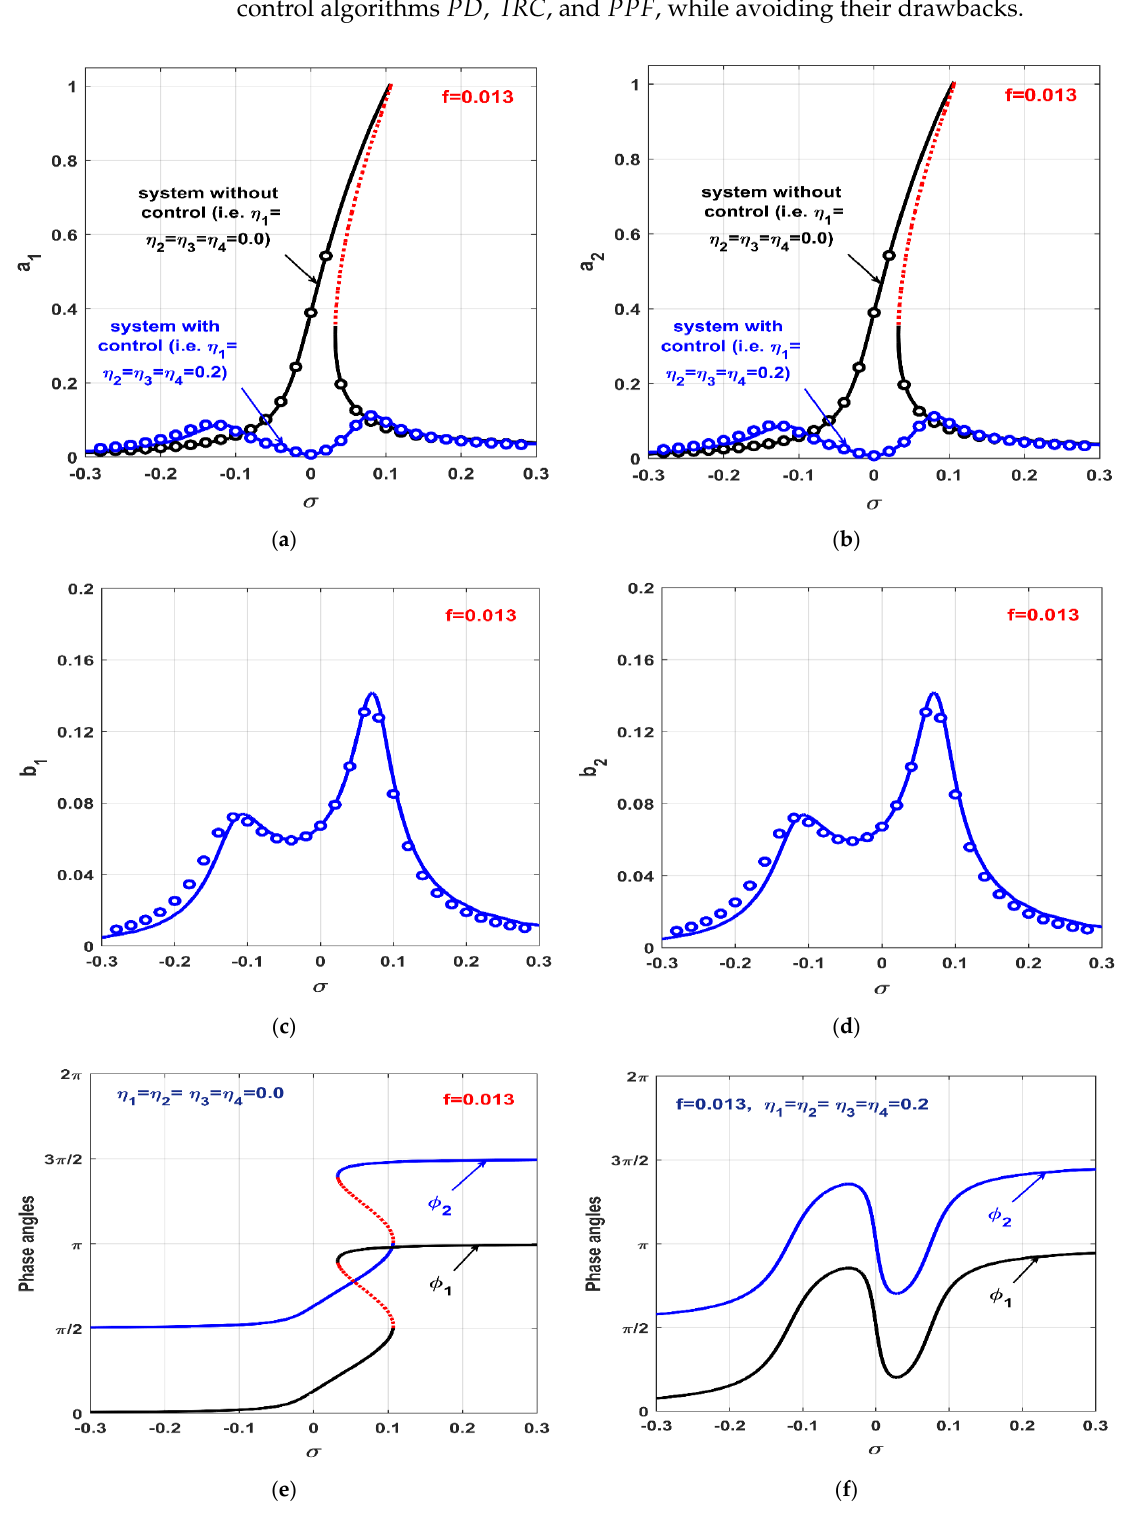
Figure 17. Vibration amplitudes and phase angles of the twelve-poles rotor in the case of both the PD -control algorithm only and the PD + IRC + PPF -control algorithm when f = 0.013: ( a , b ) vibra- tion amplitudes ( a 1 , a 2 ) of the rotor, and ( c , d ) vibration amplitudes ( b 1 , b 2 ) of the PPF controller, ( e ) phase angles ( φ 1 , φ 2 ) when η 1 = η 2 = η 3 = η 4 = 0.0, and ( f ) phase angles ( φ 1 , φ 2 ) when η 1 = η 3 = η 2 = η 4 =